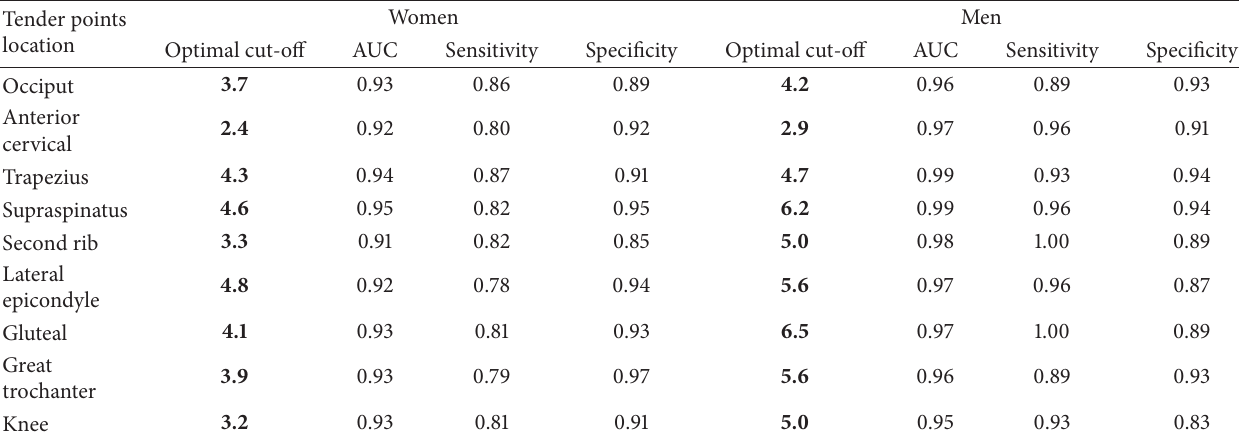
Table 6: Test characteristics of tender points’ criteria for classifying fibromyalgia using clinical diagnosis as the gold standard in both fibromyalgia and nonfibromyalgia women ( 𝑛 = 666 ) and men ( 𝑛 = 82 ). Women Men Tender points location Optimal cut-off AUC Sensitivity Specificity Optimal cut-off AUC Sensitivity Specificity Occiput 3.7 0.93 0.86